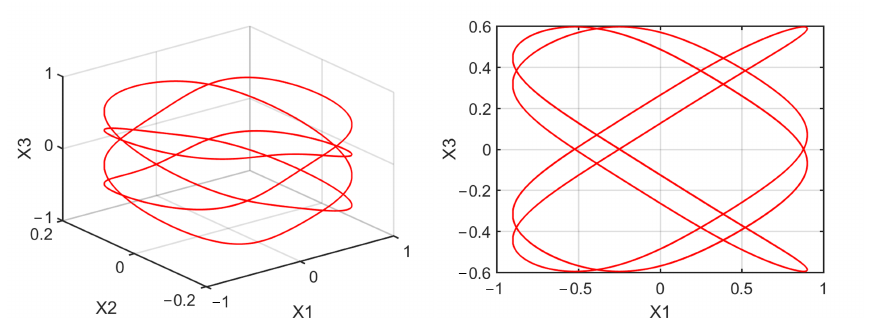
Figure A1. Periodic-1 motion of σ 2 = 3.3647.